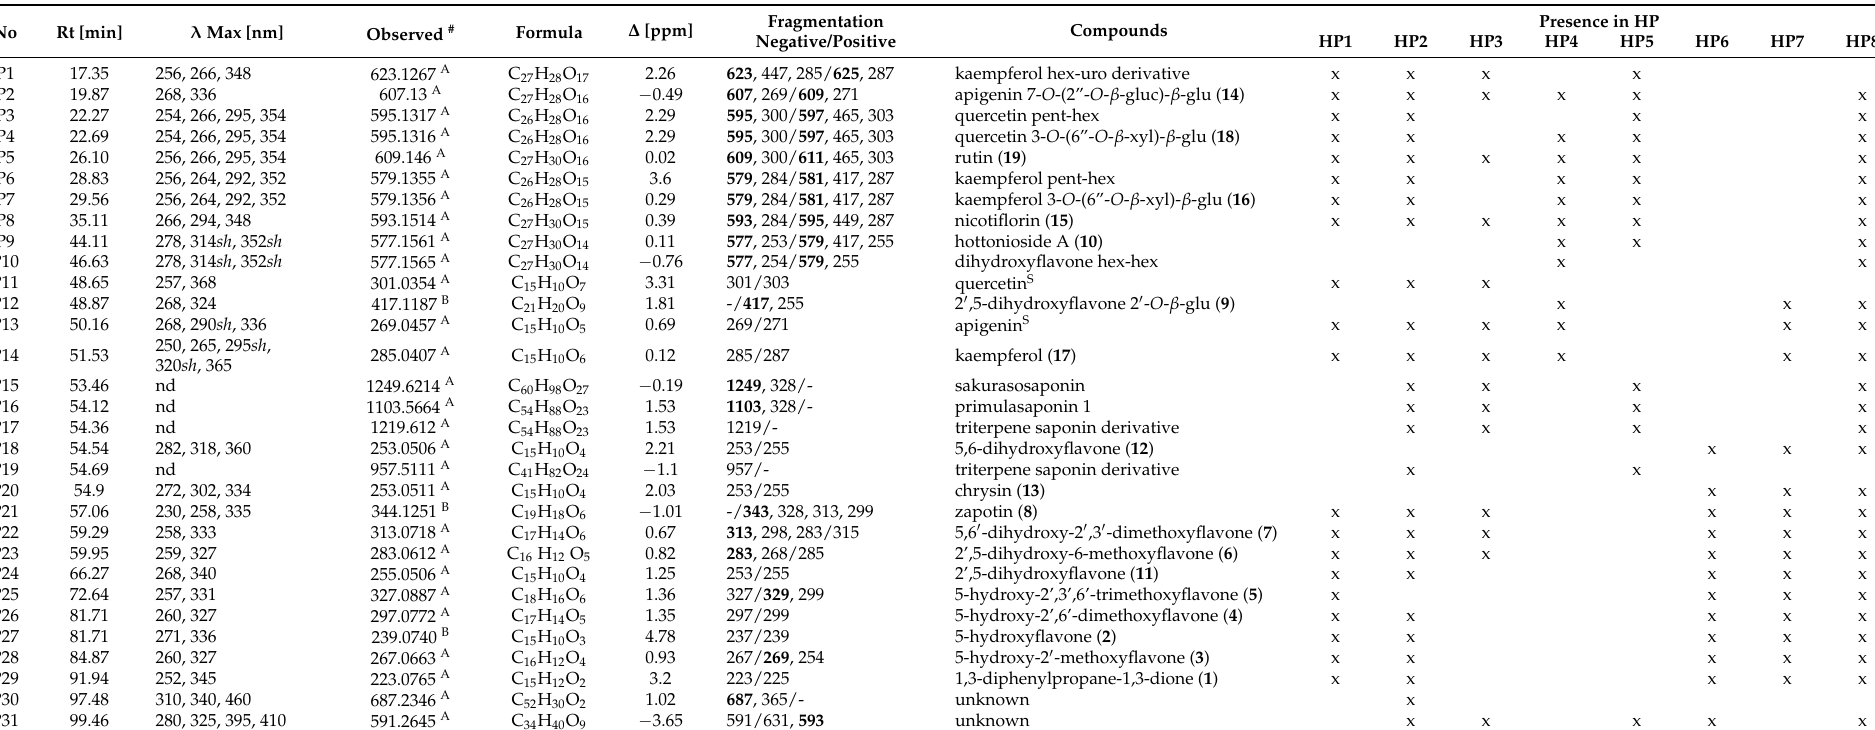
Table 2. The UV–Vis and MS data of compounds identified in HP1–HP8 by liquid chromatography–photodiode detection array–high-resolution mass spectrometry